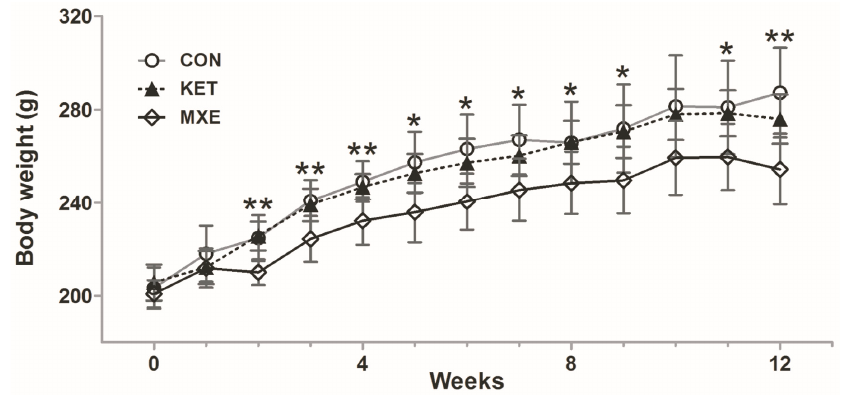
Figure 1. Effect of ketamine and methoxetamine on body weight of rats over a 12-weeks period. Rats were injected with normal saline (CON, n = 6), 30 mg/kg methoxetamine (MXE, n = 6) or 30 mg/kg ketamine (KET, n = 6) for a period of 12 weeks. There were significant differences between the three groups from Week 2 to Week 12 (except at 10 weeks, p > 0.05). Data are expressed as the mean ± SD, and compared with one-way ANOVA. * p < 0.05, ** p <